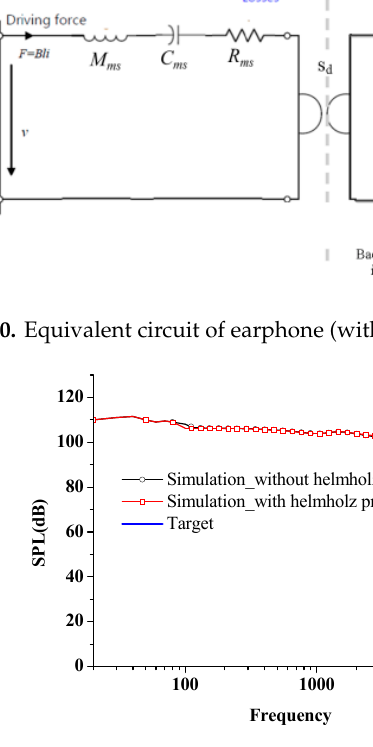
Figure 21. Simulation result (with / without Helmholtz protector).